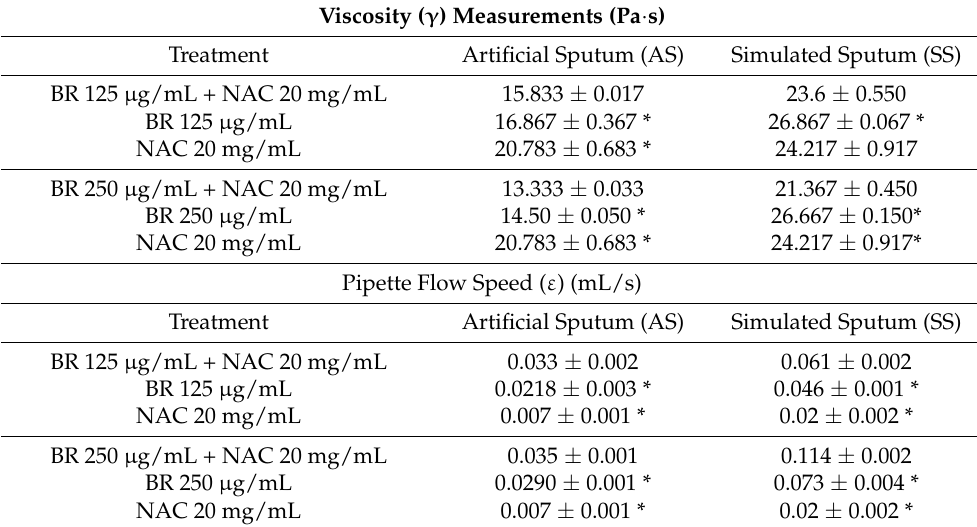
Table A1. Data presented as mean ± SD. Test samples were compared with control after treatment for significance testing; * = p <